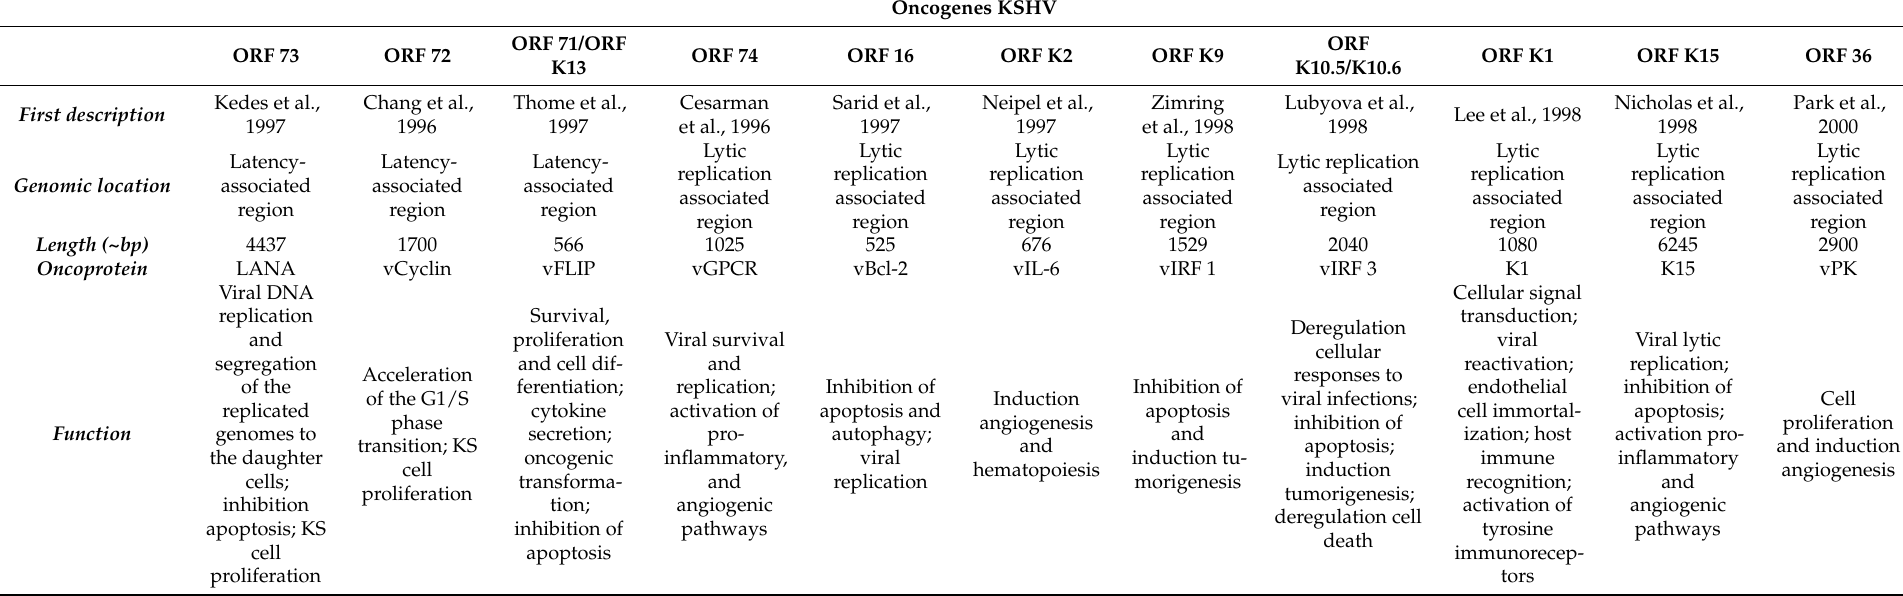
Table 1. KSHV oncogenes involved in KS